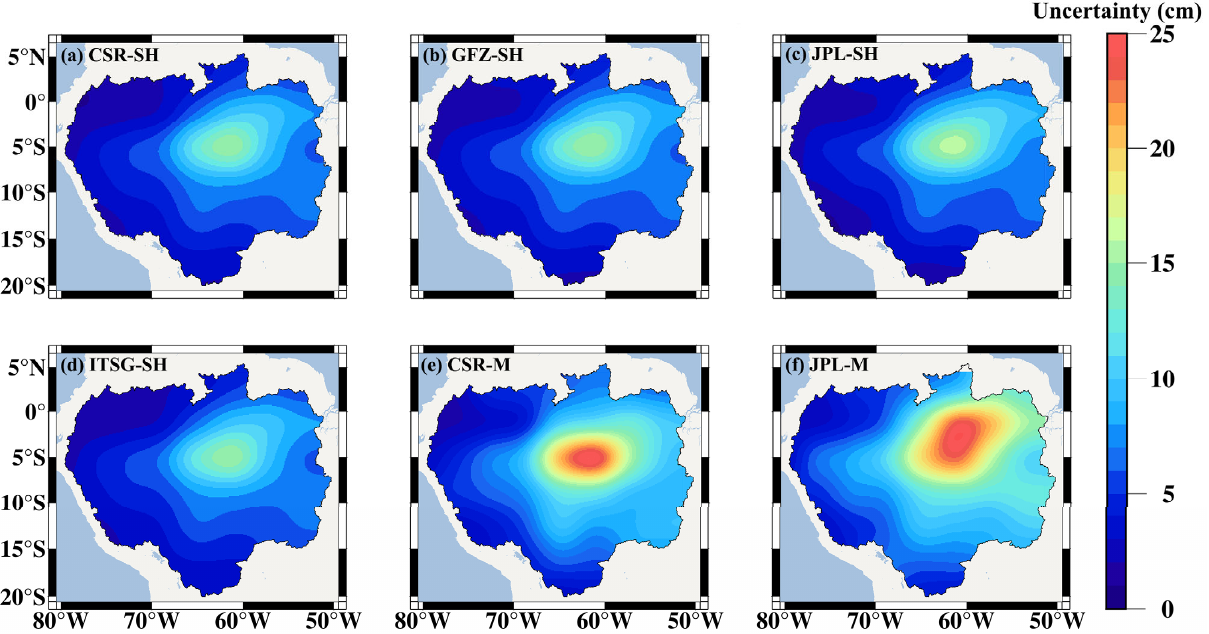
Figure 3. The spatial distribution of uncertainties of TWSC results from six GRACE solutions. Table 3. Uncertainties of TWSC results from the six GRACE solutions and fused results estimated by the GTCH